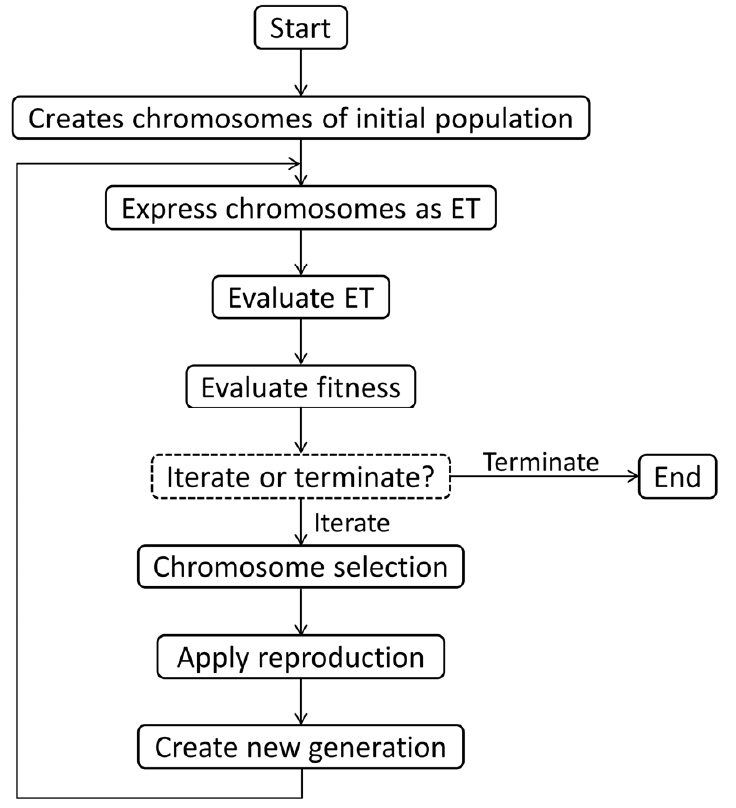
Figure 2. Flowchart of GEP algorithm (adapted with permission from [79]).